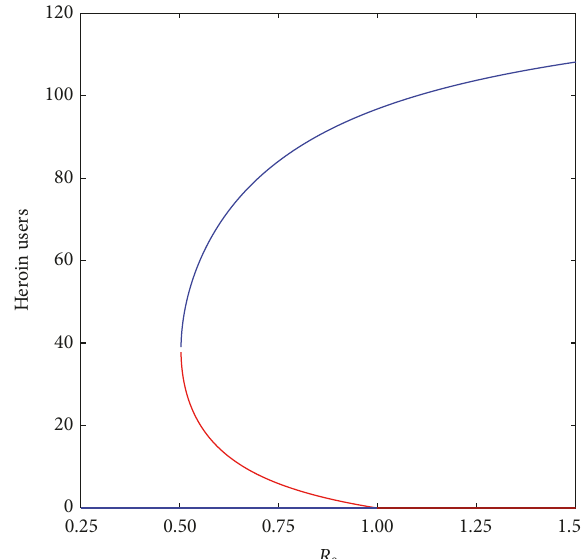
Figure 1: Illustration of the qualitative features of backward bifur- cation. The red line represents the unstable equilibria (i.e., unstable endemic equilibria and unstable heroin-free equilibrium) while the blue line represents stable equilibria (i.e., stable endemic equilibria and stable heroin-free